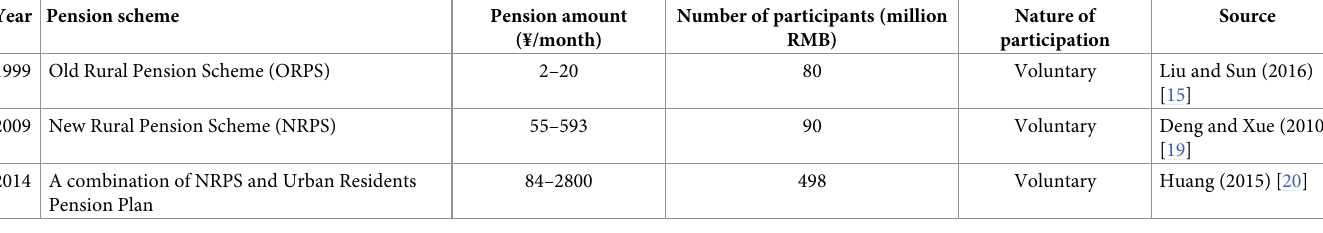
Table 1. Overview of the rural pension systems in